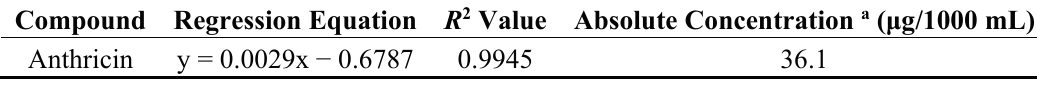
Table 3. The regression equation and R 2 value obtained from various concentration of anthricin, and the content of anthricin in the methanol extracts of C. obtusa leaves. Compound